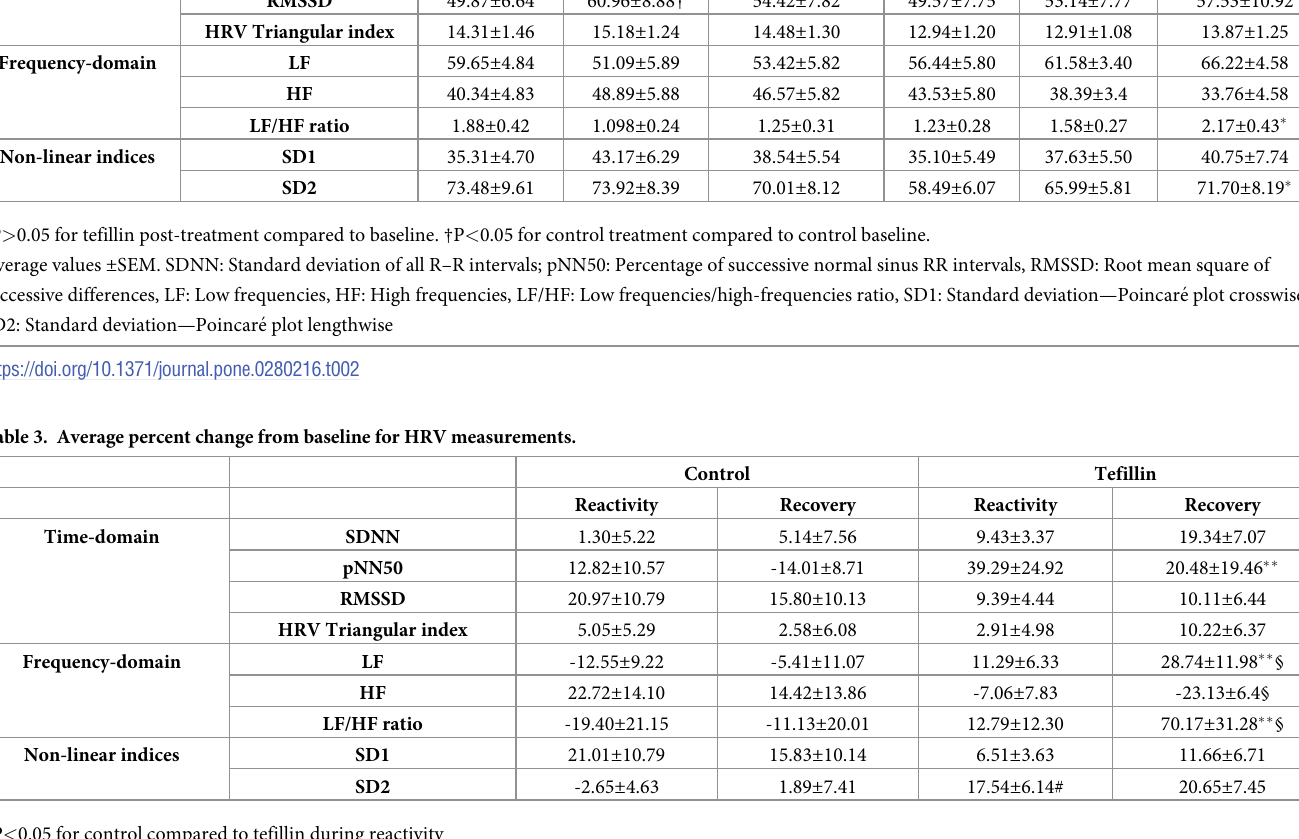
The determination of LF and HF power was performed by converting the ECG units to Hertz and then to normalized units by the Kubios software, as described in the methods. The two main frequency dependent variables, LF and HF, demonstrated changes during treatment in